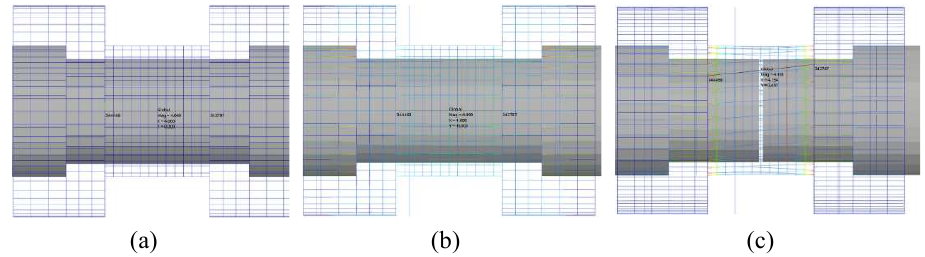
Fig. 6 : Three instants of time: (a) @start of the analysis, (b) after compression wave transit and (c) after simultaneous tension and torsion waves transit